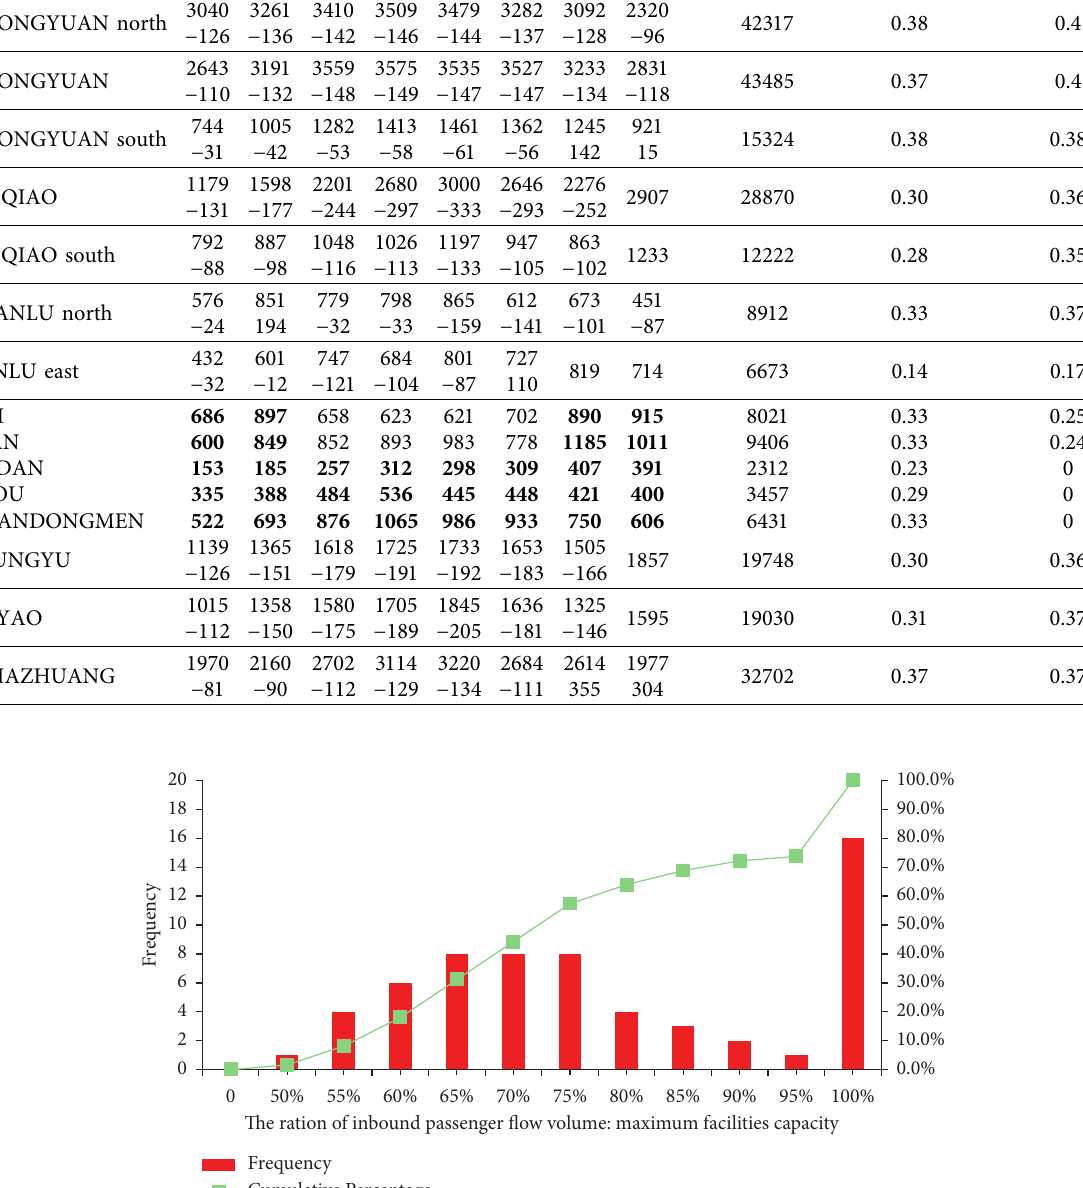
Table 7: Comparison between the actual and coordinated control strategies for Line 5. Station